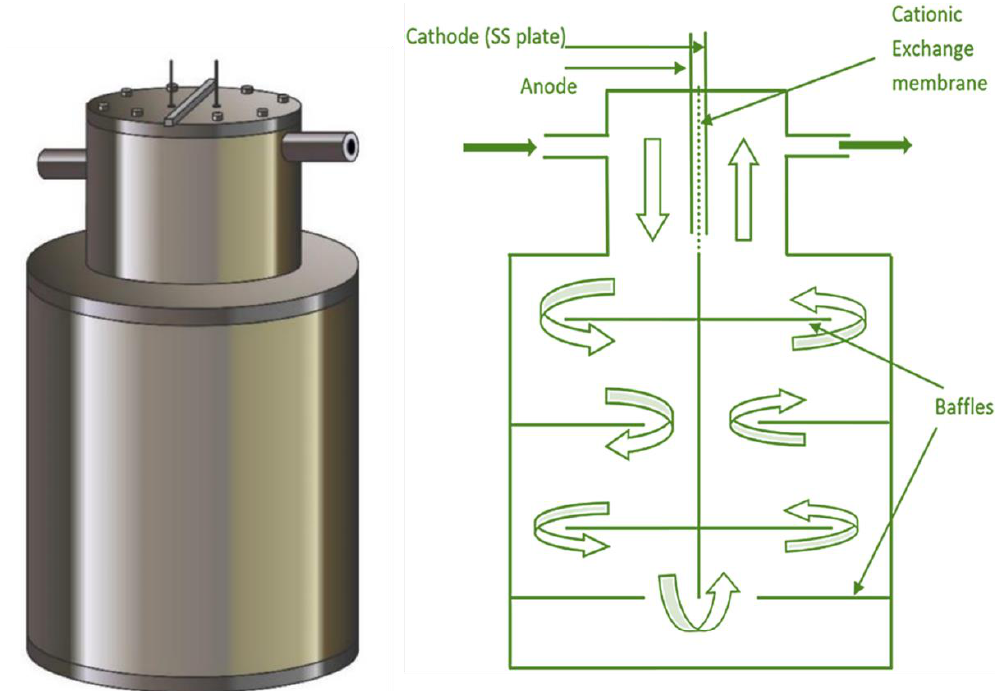
Figure 8. Schematic and cross-sectional diagrammatic representation of single-household EC setup showing the upper electrolysis cell and the bottom baffle-fitted hold tank, as reported by Guruprasad et al. Reused under the Creative Commons license [43] .